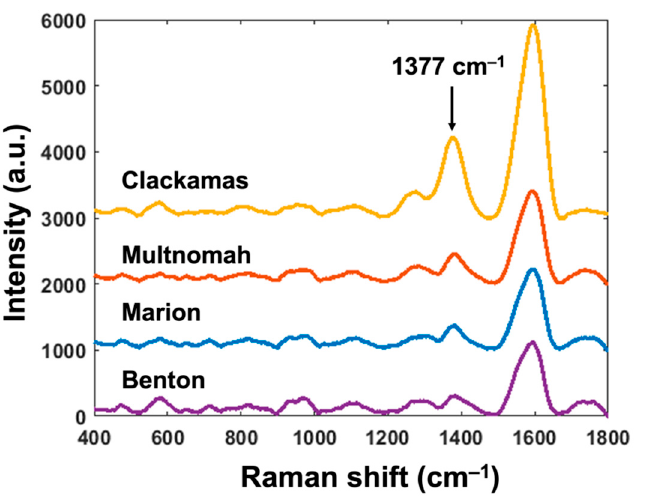
Figure 4. The SERS results from different counties.